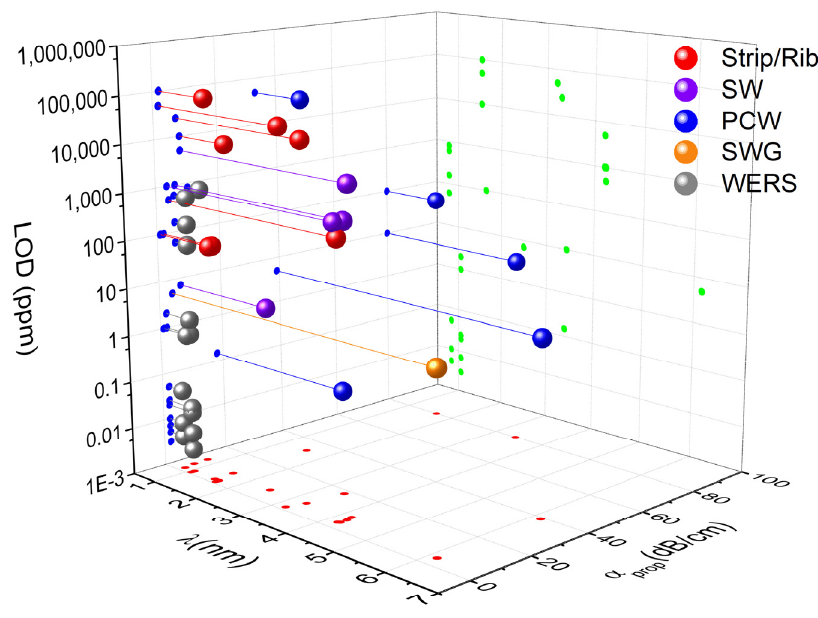
Figure 6. Technology map. A 3D plot of various representative sensing structures, categorized according to their working wavelength l (x-axis), propagation losses α prop (y-axis), and LOD (z-axis). Legend: strip/rib waveguides (strip/rib), suspended waveguides (SW), photonic crystal waveguides (PCW), subwavelength gratings (SWG), clad waveguides used for WERS (WERS).